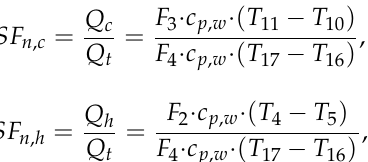
Figure 16. The irradiation onto the collector area, the collector field yield, and the cooling energy yield on 23, 25, 27, and 28 July; the heat pumps were switched off on 25, 27, and 28 July2018. In order to determine the influence of the heat pumps on the system performance, the heat pumps were switched off on 25, 27, and 28 July 2018 and the system performance was analyzed. As